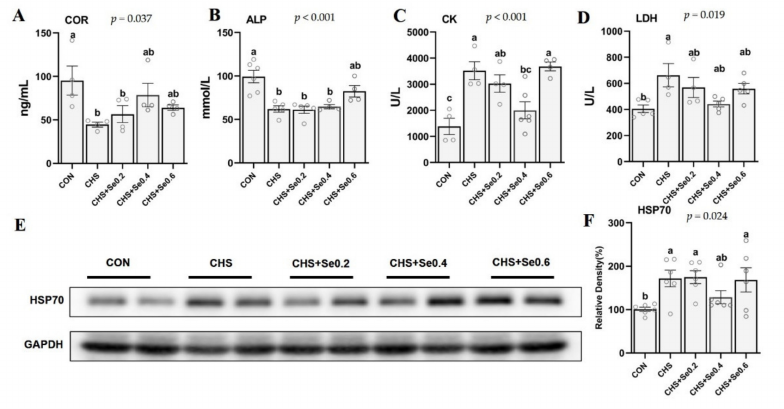
Figure 4. Effects of CHS and OH-SeMet supplementation on serum endocrine ( A ),